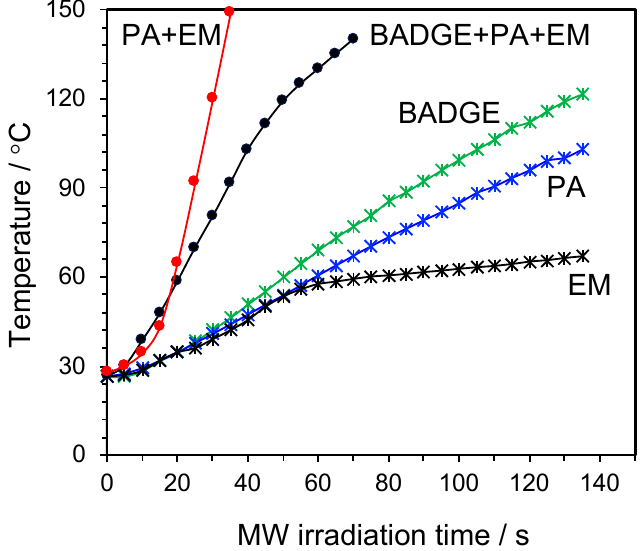
Figure 4. Temperature changes resulting from microwave irradiation by the electric field ( E -field; 10 W) using a single-mode applicator and a semiconductor microwave generator for each of the components (BADGE, PA, EM) and for the mixtures (BADGE + PA + EM) and (PA + EM).